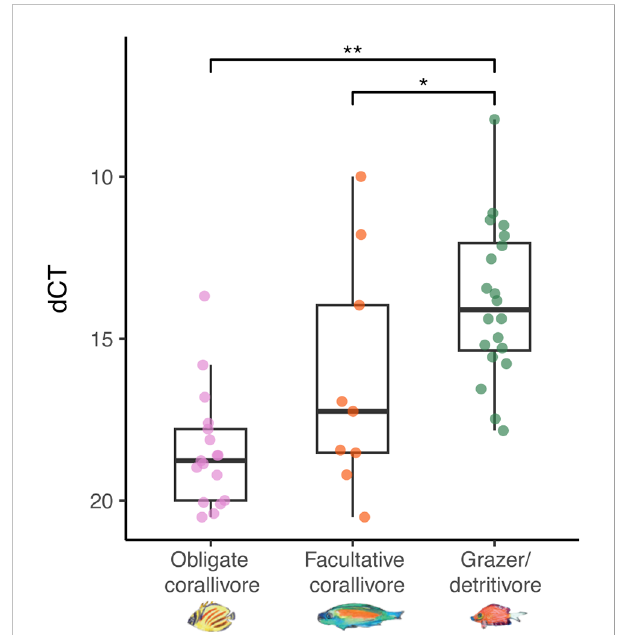
FIGURE 5 Relative abundances of Vibrio coralliilyticus metalloprotease genes were higher in grazer/detritivore feces than obligate corallivore and facultative corallivore feces (overall ANOVA results: F (2,45) = 16.14, p < 0.001). Delta cycle threshold (dCT) was calculated by subtracting the cycle threshold for the general bacteria assay from the V. coralliilyticus assay; therefore, samples with lower dCT values contained higher relative abundances of V. coralliilyticus . Ampli fi cation of the target gene at <30 cycles was counted as a positive detection; negative detections were not included in the analysis. Note that the y-axis has been inverted to make interpretation of the results more intuitive. P-values: * < 0.05; ** <